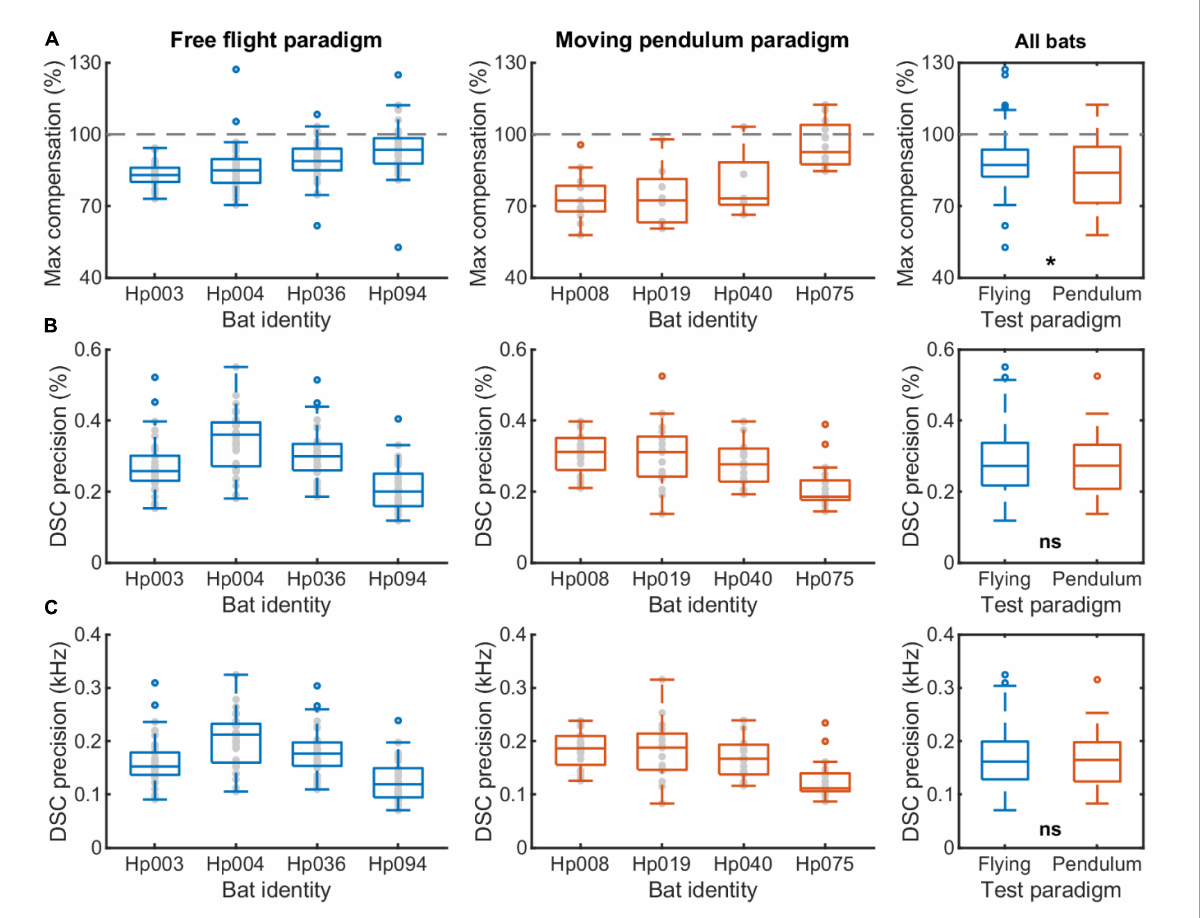
FIGURE6 A comparison of the DSC performance of Hipposideros pratti between the free flight and moving pendulum paradigms. (A) Maximum compensation magnitude in percentage. 100% indicates a full compensation for the flight speed induced echo frequency change due to the Doppler effect based on the resting frequency before flying or pendulum swing onset. (B) DSC precision in percentage, which was the ratio between the standard variation to the average of the echo frequencies during the forward swing. (C) DSC precision in kHz, which was the standard variation of the echo frequencies during the forward swing. The sample size for the four individuals, i.e., the number of trials, ranged from 34 to 36 in the free flight experiment, and from 18 to 20 in the moving pendulum